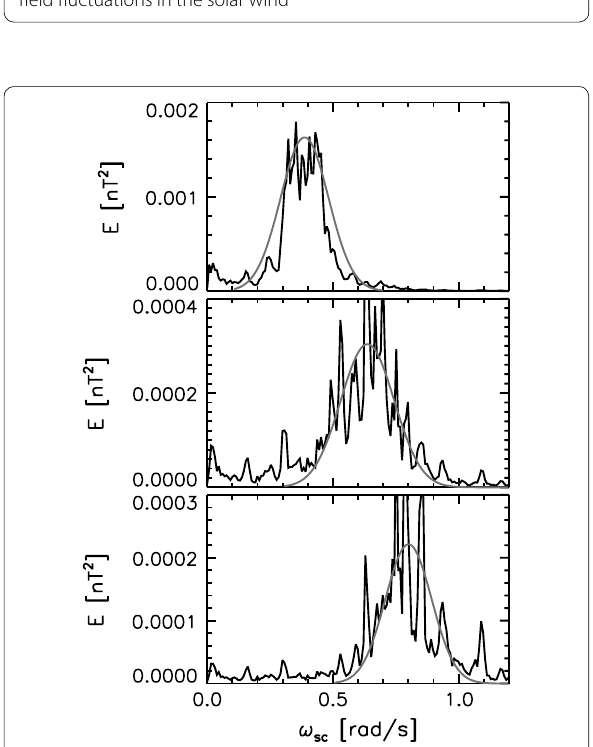
Fig. 5 Slices of the energy spectrum over frequencies at differ- ent wavenumbers and Gaussian fitting curves using the spectral moments